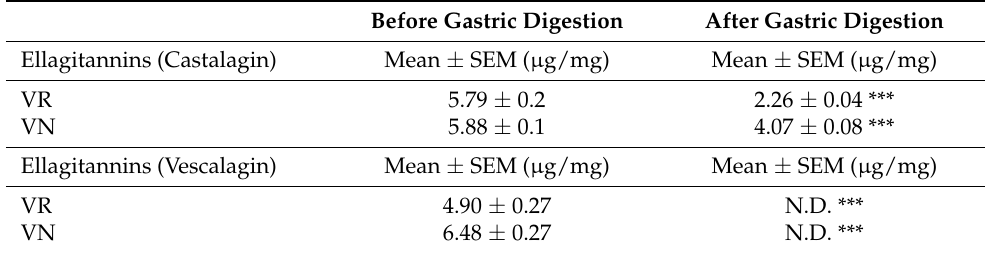
Table 3. Characterization of ellagitannins from Castanea sativa Mill. leaf extracts. Before Gastric Digestion After Gastric Digestion